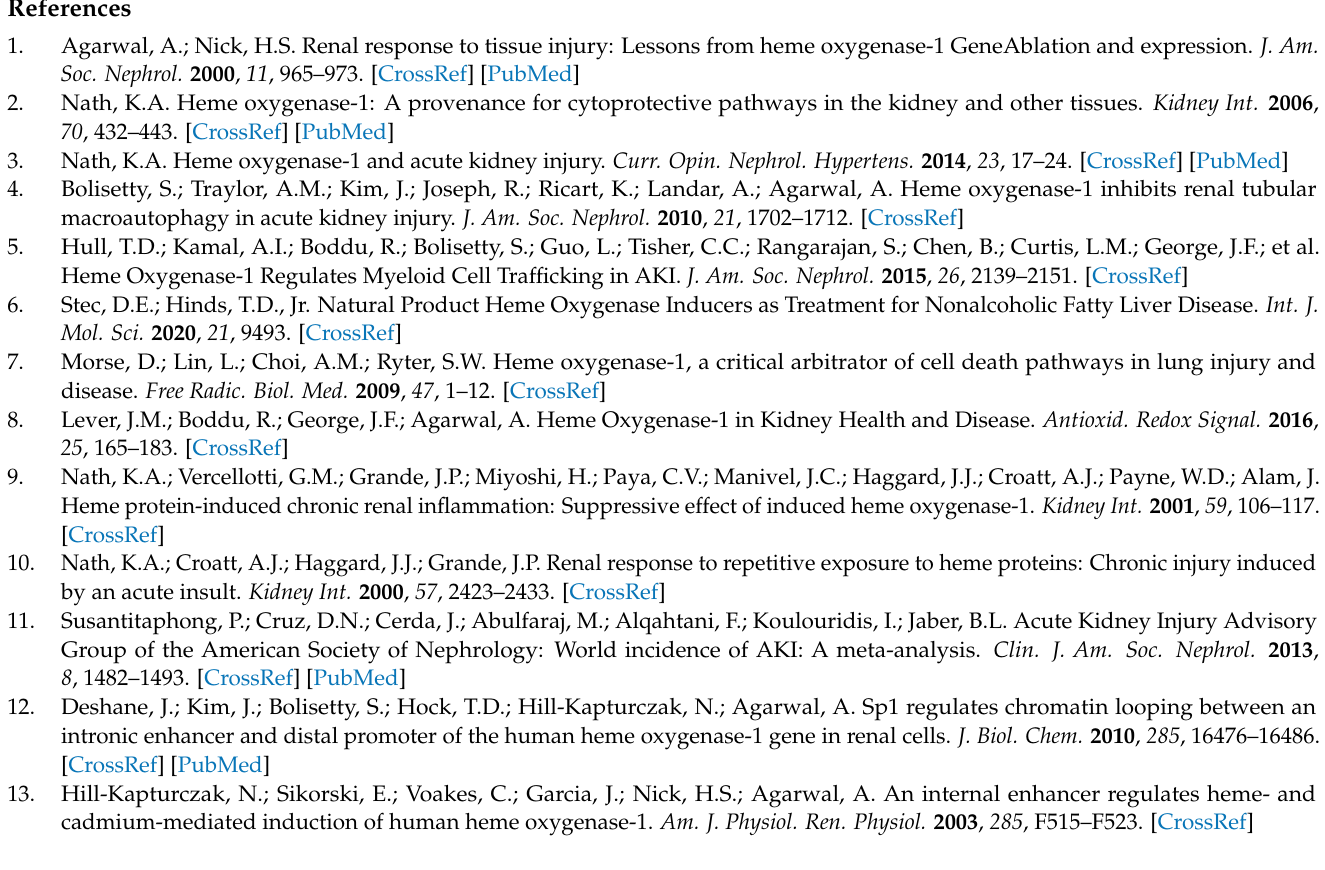
Figure S2. Luciferase expression in primary and secondary counter luciferase assays; Figure